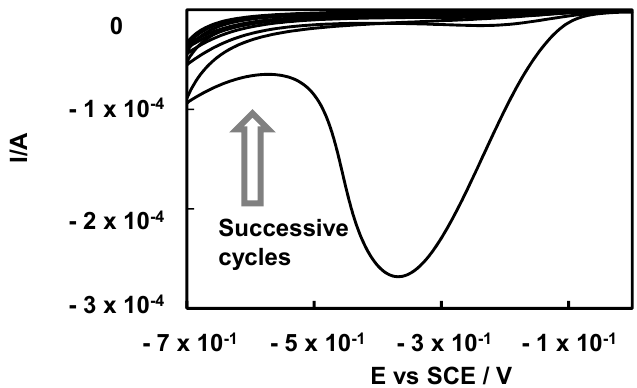
Figure 1. Cyclic voltammograms (scans 1–3) at fluorine tin oxide (FTO) electrode in HCl 0.5 M + 2 × 10 –3 M 4-aminobenzoic acid + 2.2 × 10 –3 M NaNO 2 . Scan rate of 0.1 V ∙ s − 1 . By courtesy of C. Cannizzo.